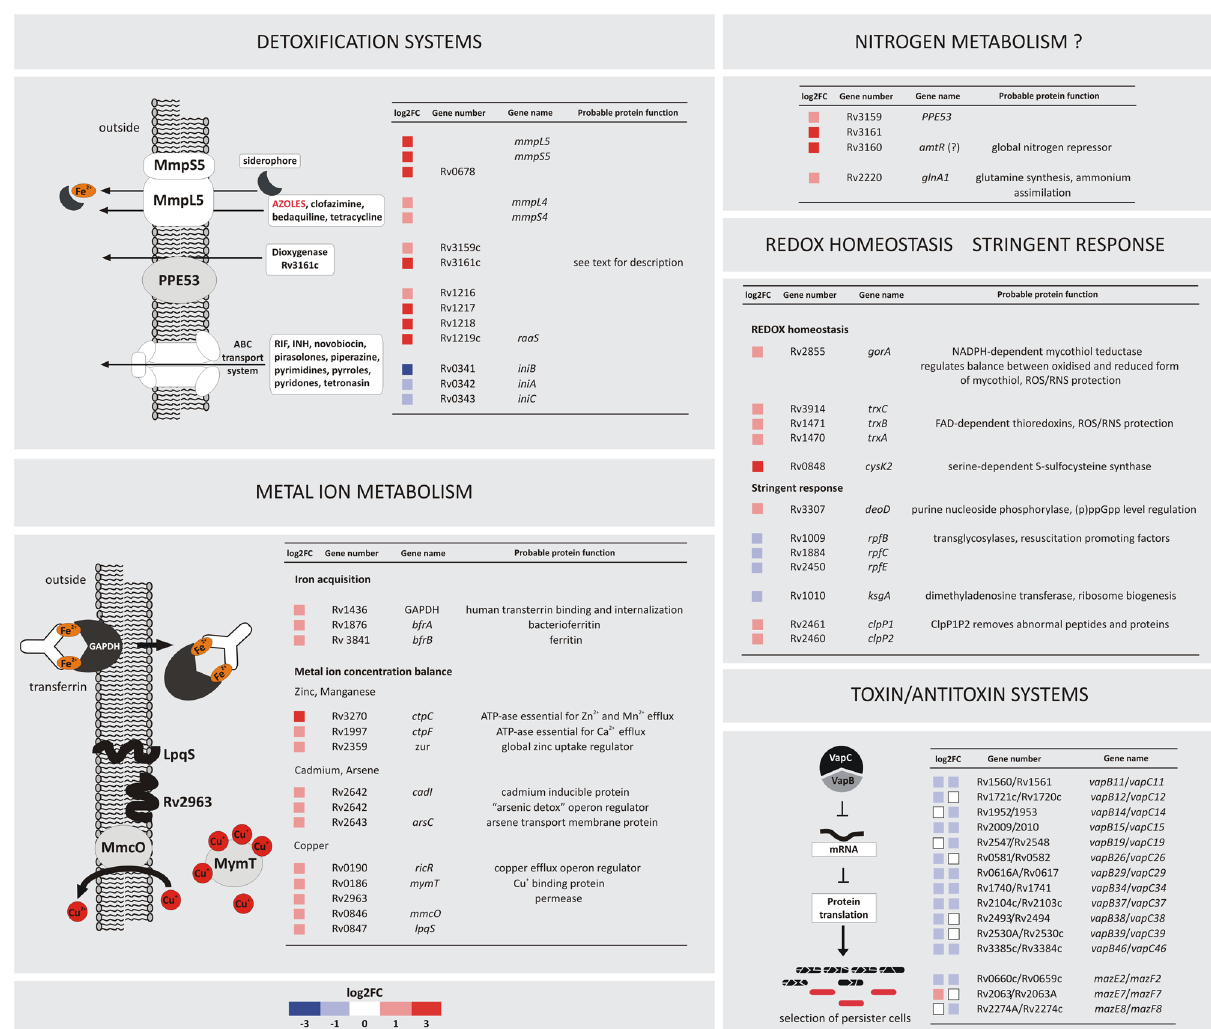
Figure 7. Examples of Mtb metabolic pathways that are modulated in a cholesterol-rich environment. Changes in the expression of the selected representative genes are shown. See the color key for log2FC